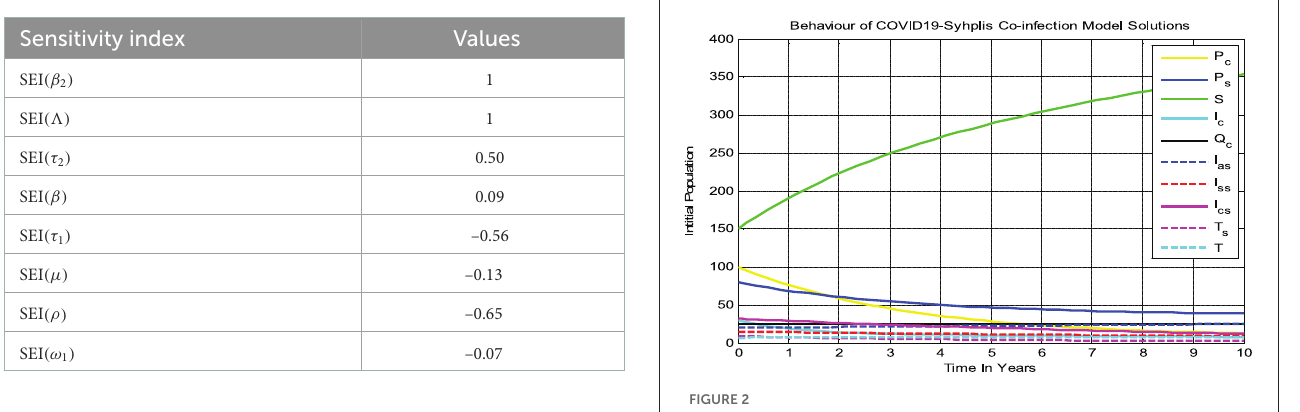
TABLE 5 Sensitivity indexes of R cs 0 = R s 0 .